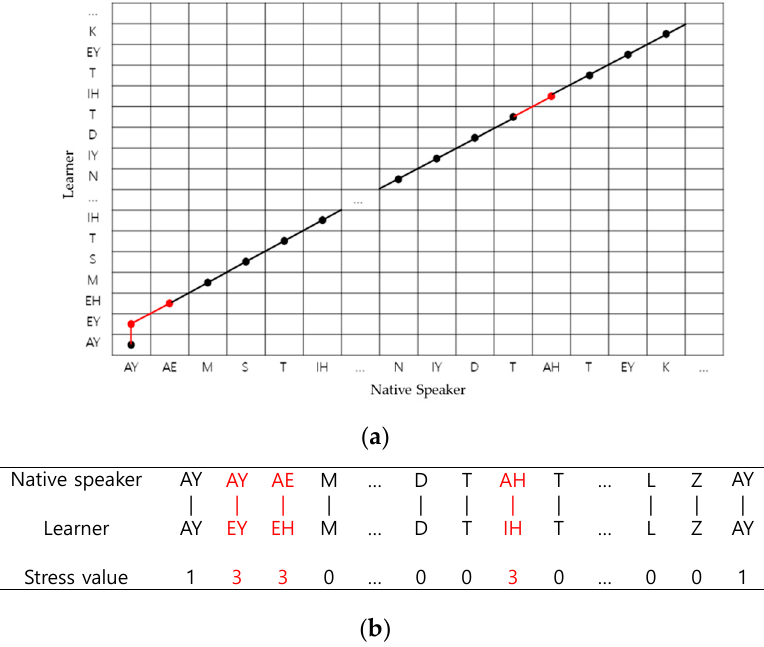
Figure 5. Example of DTW-based phonemic sequence alignment in sentence “I am still very sick. I need to take some pills.” ( a ) Aligned alignment path of the phonemic sequences. ( b ) Aligned phonemic sequence and stress values.